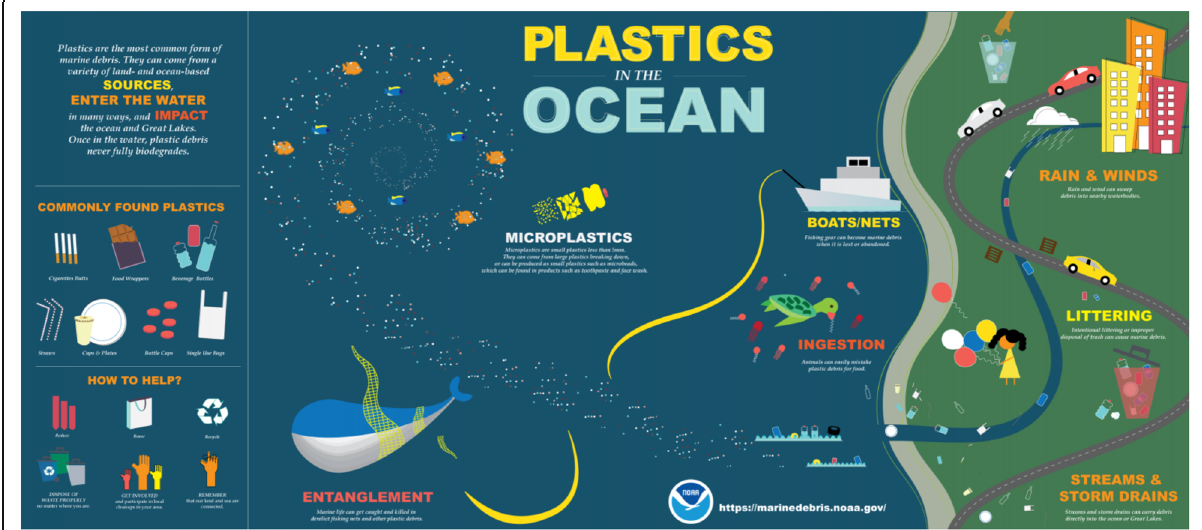
Fig. 1 NOAA Infographic: Plastics in the